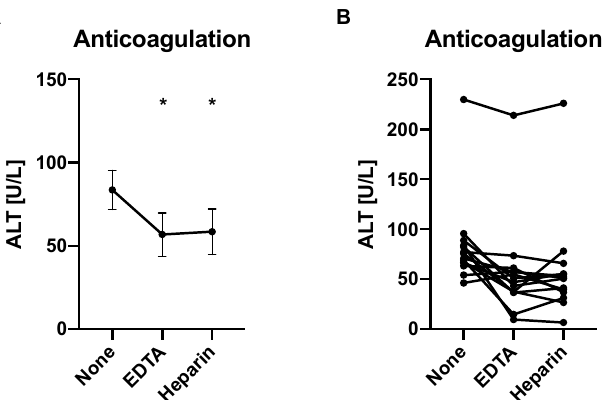
Figure 3. Anticoagulation with ethylenediaminetetraacetic acid (EDTA) or heparin results in lower ALT levels compared with no anticoagulation. Blood samples from mice ( n = 14) were obtained without anticoagulation (“serum”), with EDTA (“EDTA-treated plasma”), or with heparin (“heparinized plasma”), respectively, from each mouse. ( A ) Average ALT levels for each group. ( B ) Separate ALT levels for each mouse by anticoagulation group. Results expressed as mean ± s.e.m. p values are determined by one-way paired ANOVA with Holm-Šídák’s post hoc test. * p < 0.05.